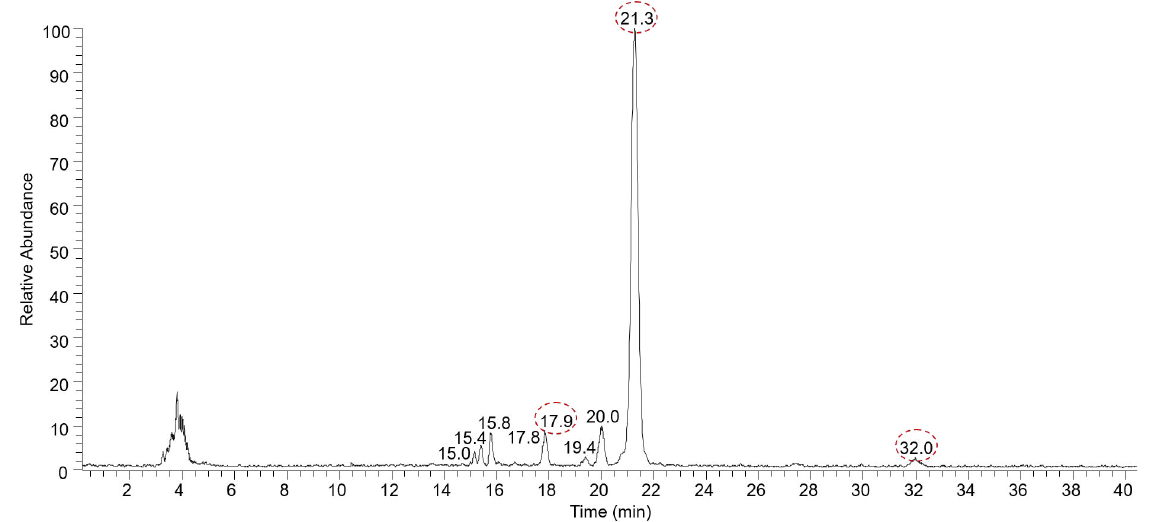
Fig. 8: Base peak chromatogram (HPLC-DAD-ESI-MS/MS) of a representative Kalanchoe fedtschenkoi aqueous leaf-extract (2 mg/mL) in the negative ion mode. Marked peaks correspond to substances identified based on comparison with pure compounds: kaempferol 3- O -glucopyranoside 7- O -rham-